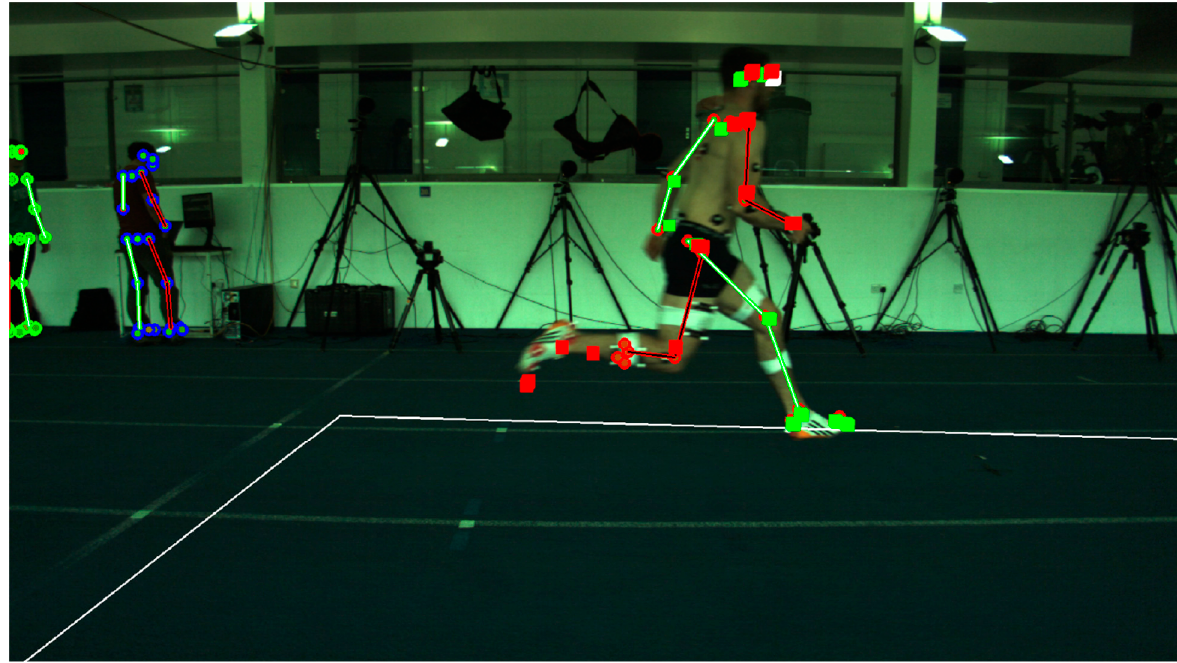
Figure A3. OpenPose keypoint detection examples depicting pose estimation during sprinting. Blue circles depict the 2D OpenPose keypoint locations with the circle fill colour representing the left (green) and right (red) sides of the body. Cubes depict the 3D reconstructed joint centres for the left (green) and right (red) sides of the body projected onto the 2D image plane. This example demonstrates overall good quality 2D detections and 3D reconstruction. Errors in the detection of the right foot can be observed, however, this will largely be corrected during the 3D fusion process which will use detections from other fields of view.